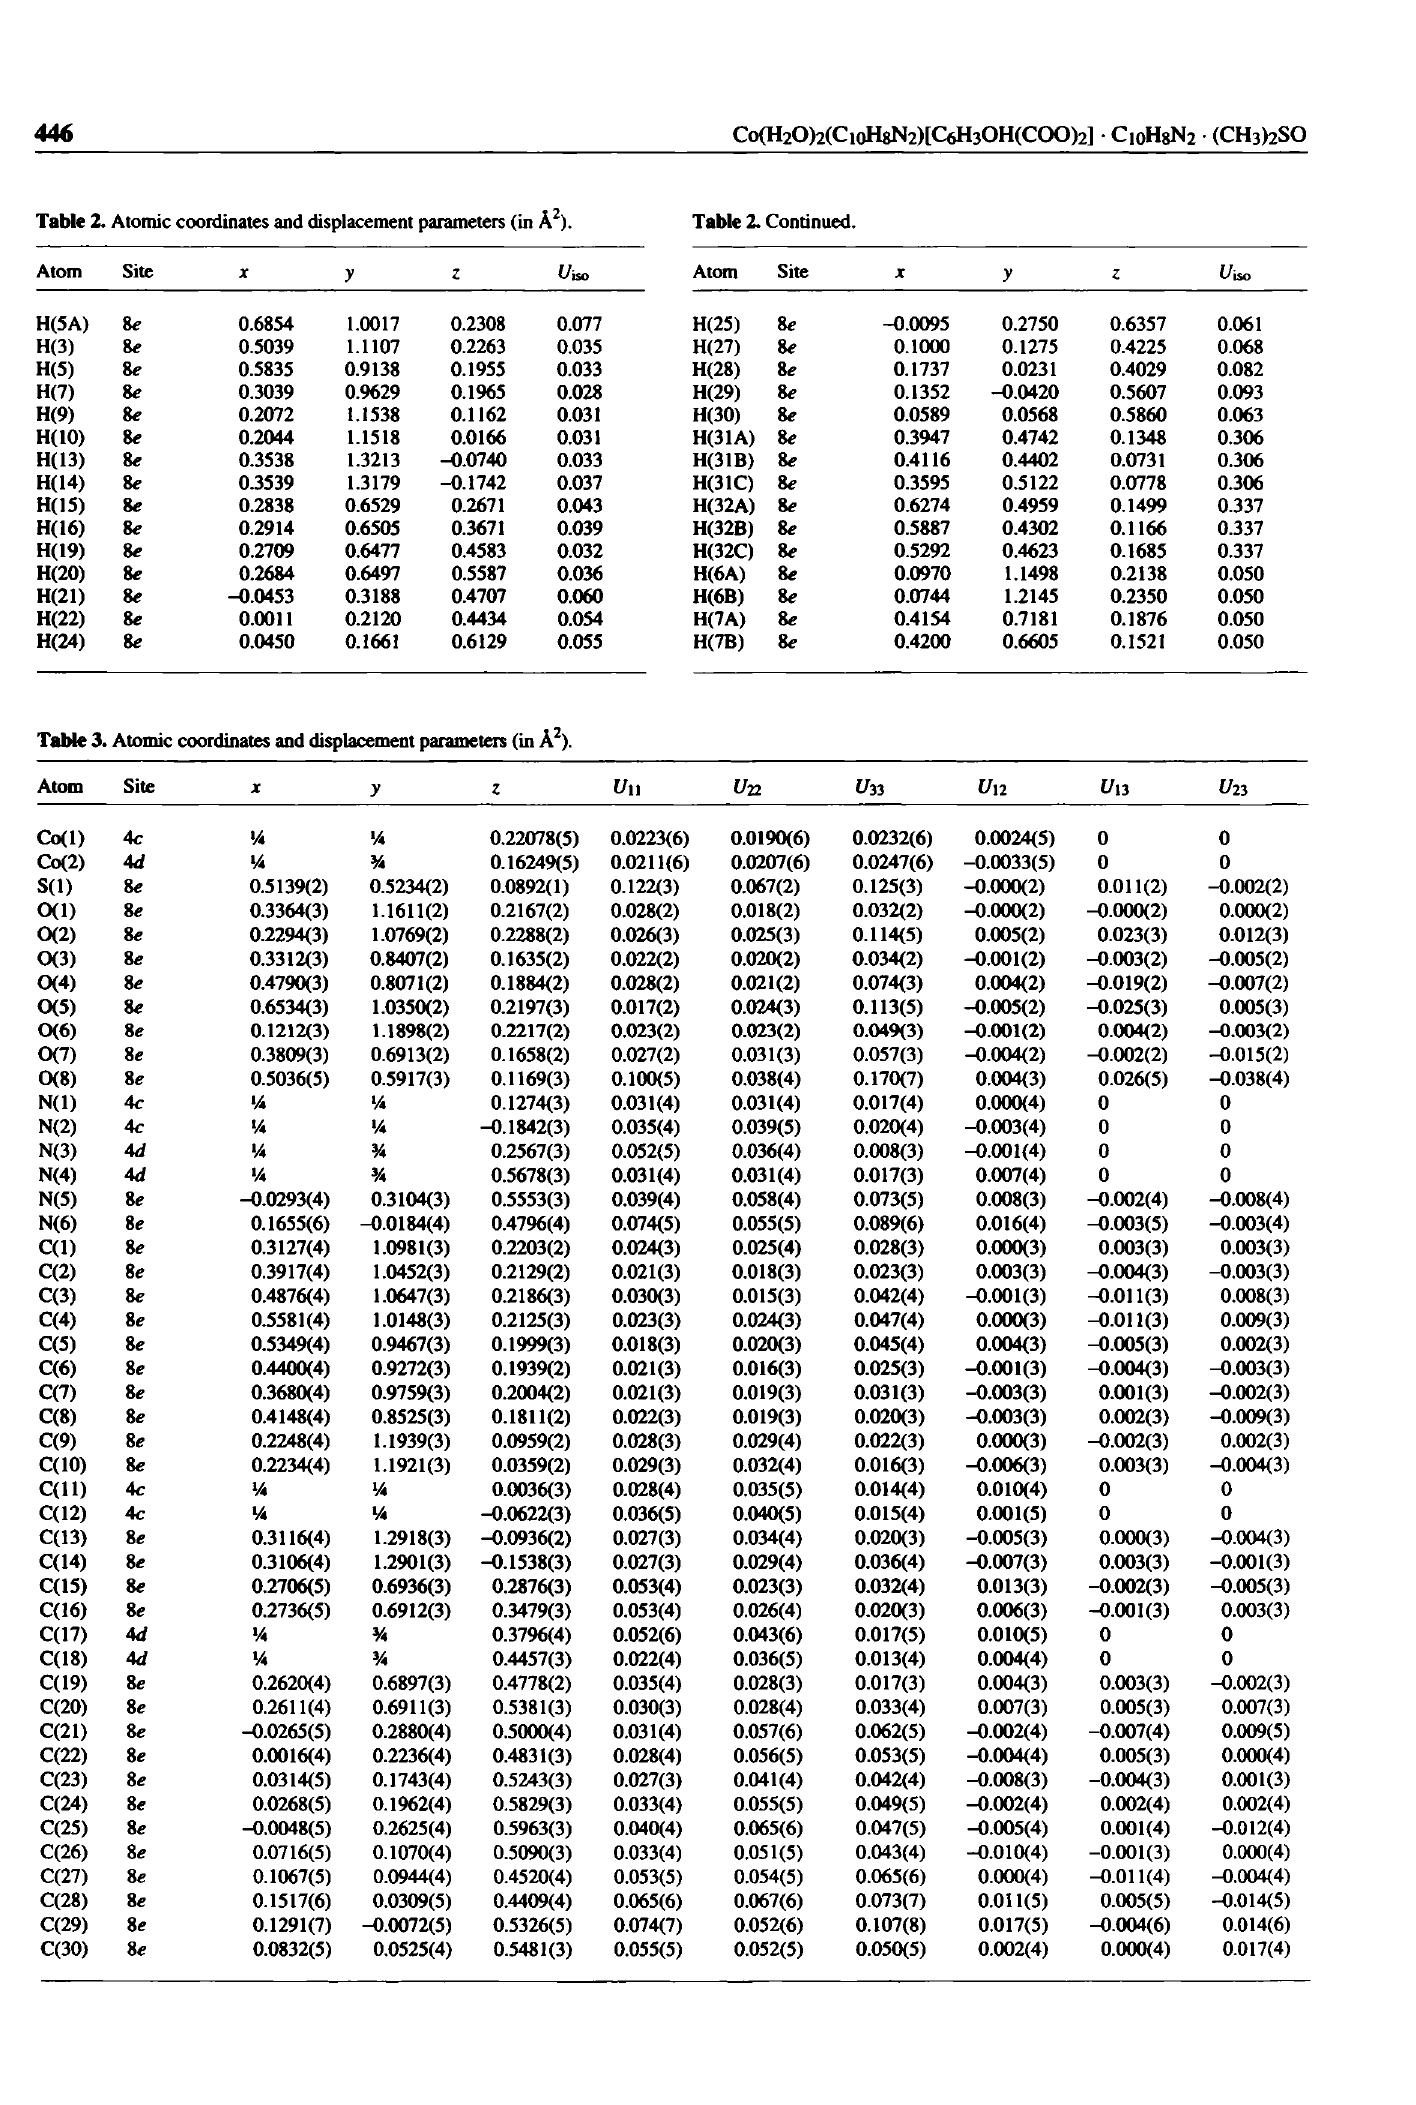
Table 3. Atomic coordinates and displacement parameters (in A 2